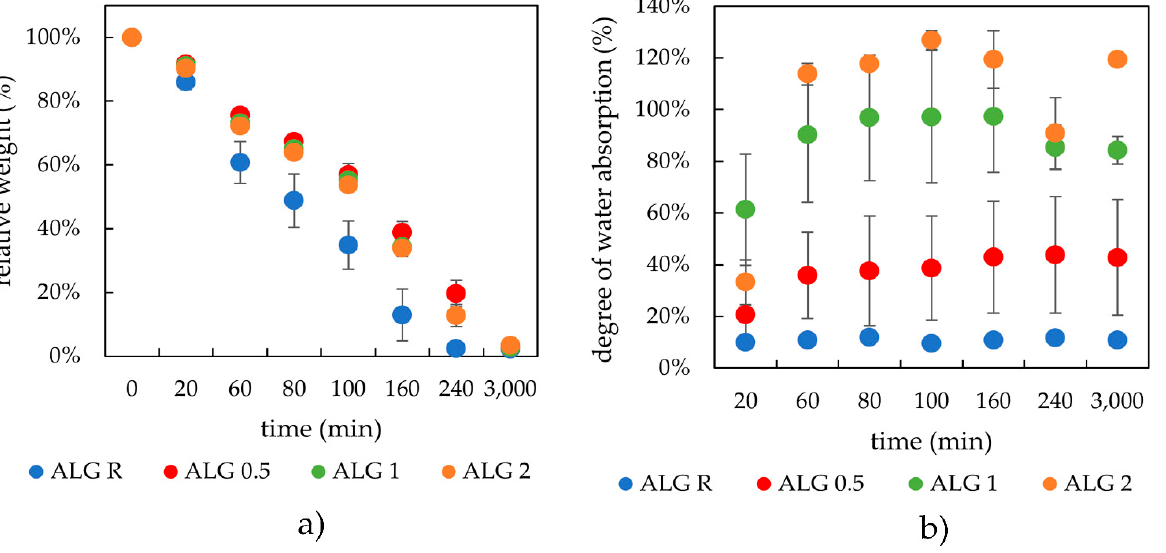
Figure 5. Drying ( a ) and rehydration ( b ) of ionically crosslinked alginate hydrogels with different lecithin content.